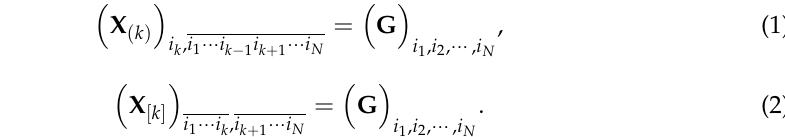
Figure 2. Visualization of a 5-order tensor train decomposition in graphical notations.